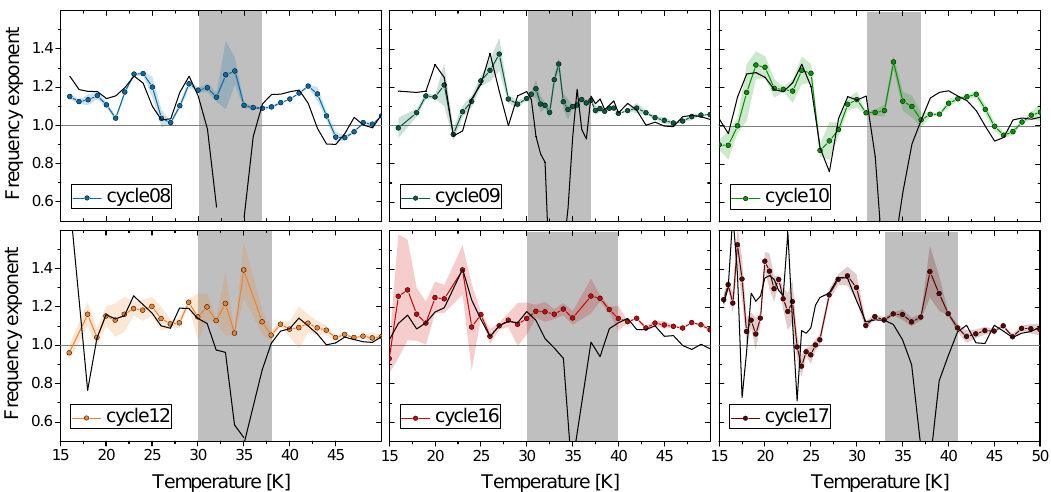
Figure 13. Temperature dependent frequency exponent α for some selected warming cycles. The black line corresponds to the values determined with the DDH model; the grey shaded area emphasizes the temperature region where the DDH model deviates from the experimental